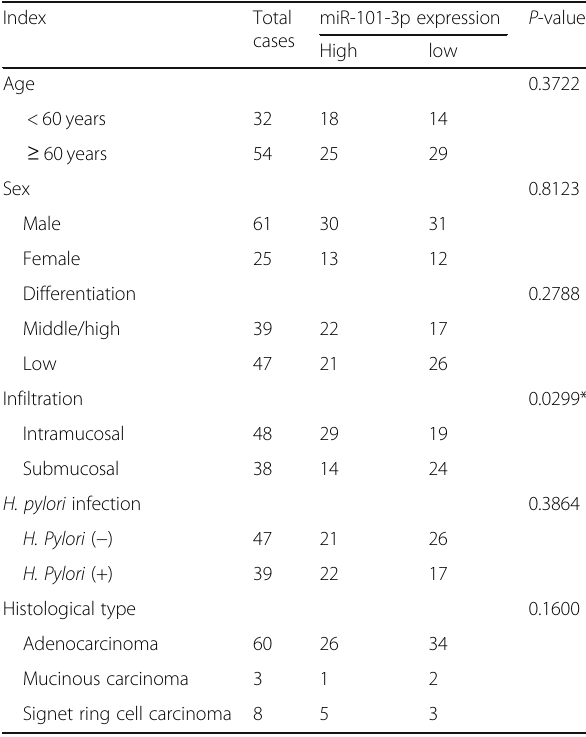
Table 2 The correlation between the expression of miR-101-3p and the baseline information of patients with gastric